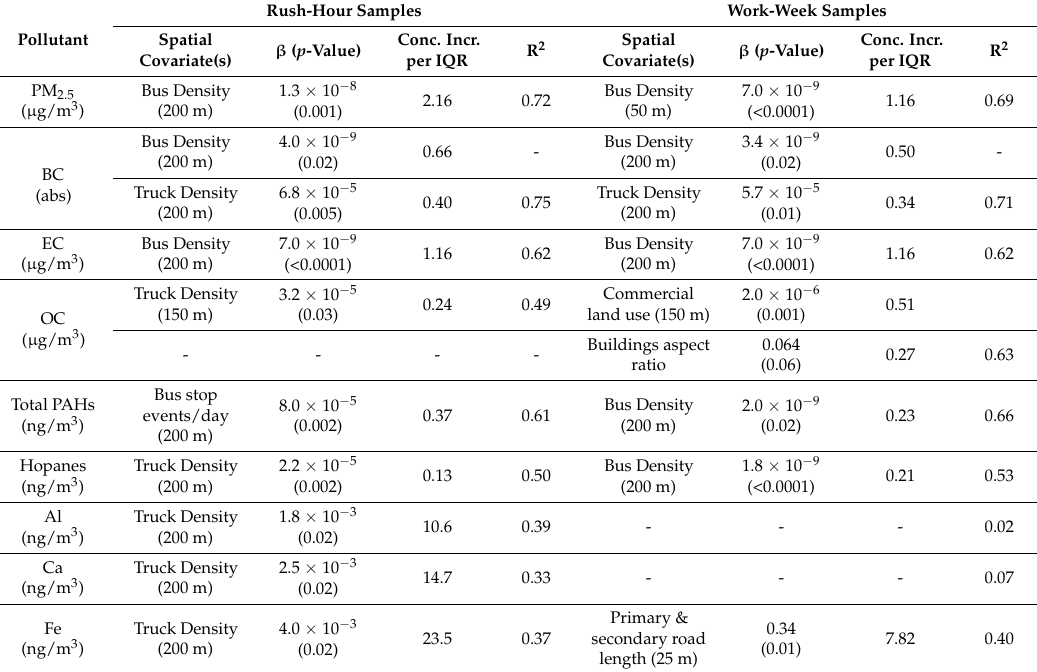
Table 4. Summer rush-hour and work-week LUR summary for all modeled pollutants. All models include a temporal term (mean reference site concentration for the